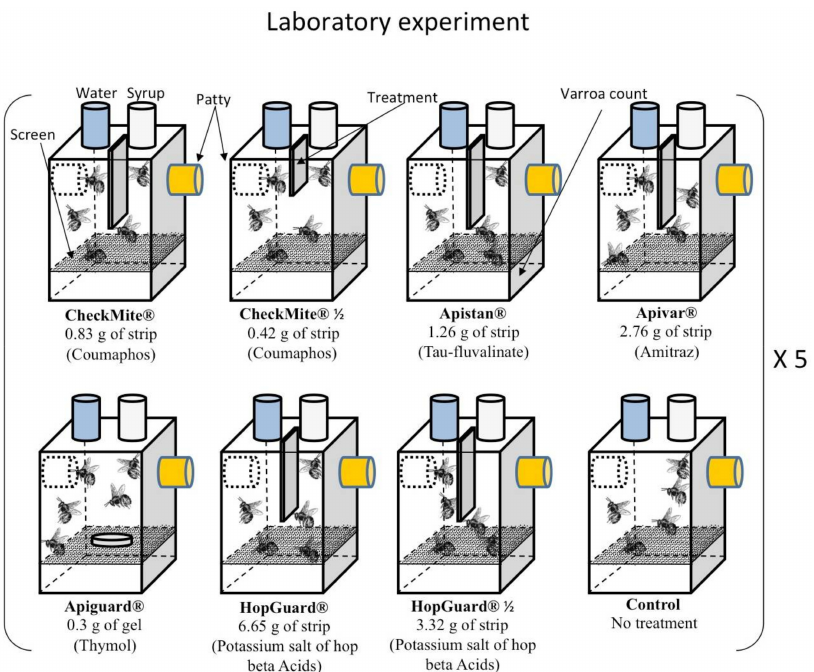
Figure 1. Experimental design and the application rates of commercial acaricides applied in each laboratory cage. The control treatment received no acaricidal treatment. Caged bees were provided with sugar syrup, water, and pollen patty. Five replicates were carried out for each treatment, for a total of 40